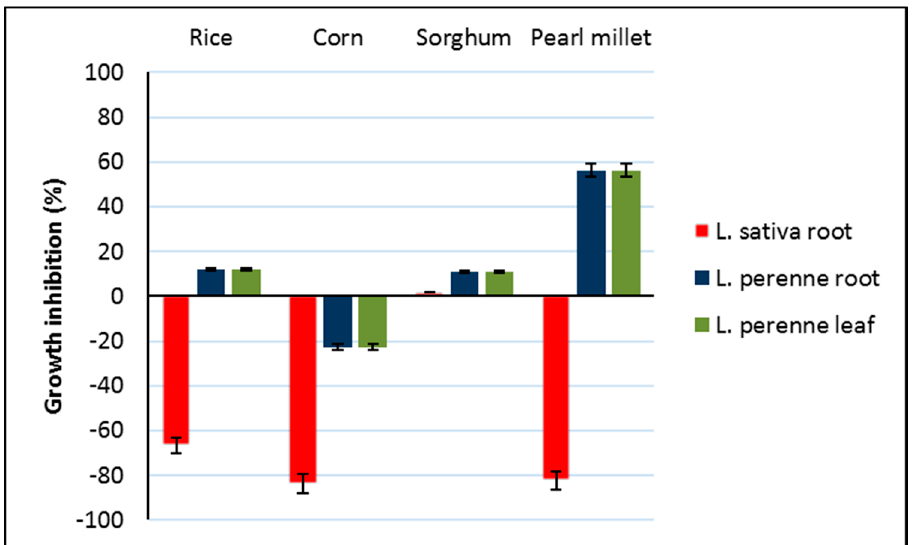
Figure 2. Phytotoxic e ff ects (% inhibition) of the di ff erent EFI671 solid media extracts on Lactuca sativa and Lolium perenne ) root and leaf growth. Bars represent the average relative values ± standard error ( n = 25 plants